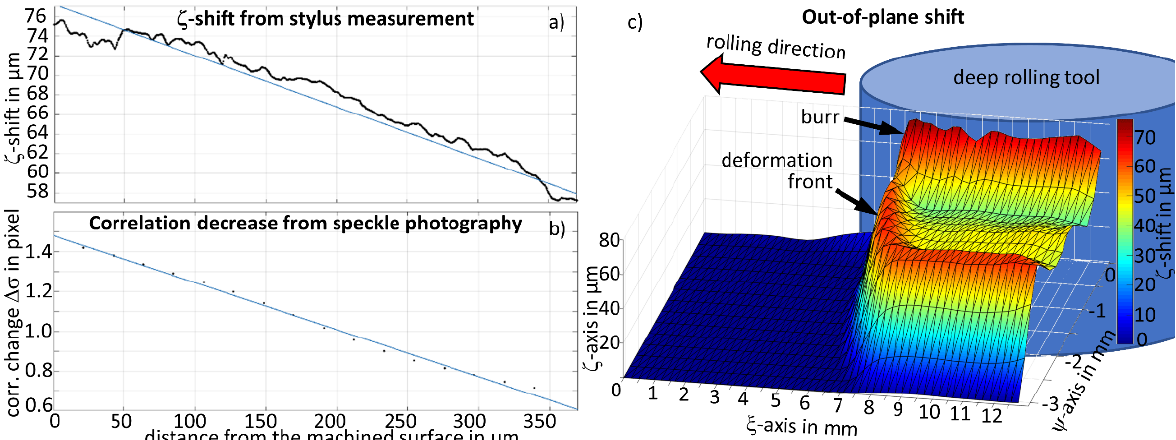
Figure 8. 3D deformation measurement in the deep rolling process. ( a ) Tactilely measured burr; ( b ) width of the correlation function as a function of the out-of-plane displacement of the burr; ( c ) speckle-photographically measured deformation field in the ζ -direction after calibration.